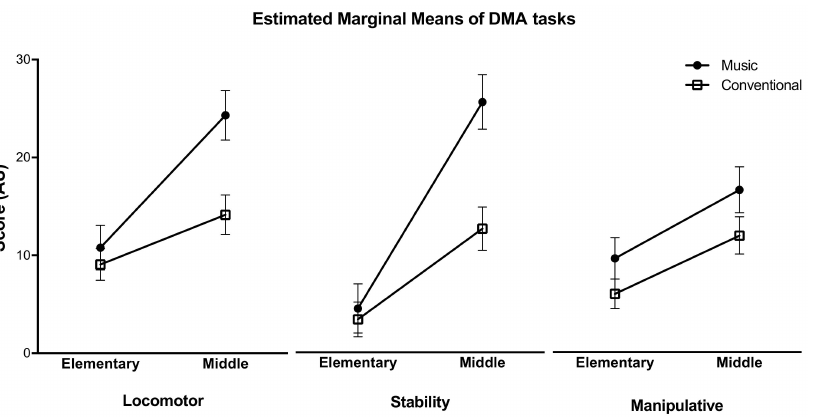
Figure 3. Estimated marginal means (output) of the locomotor, stability, and manipulative skills of the Divergent Movement Ability test in elementary and middle school students.